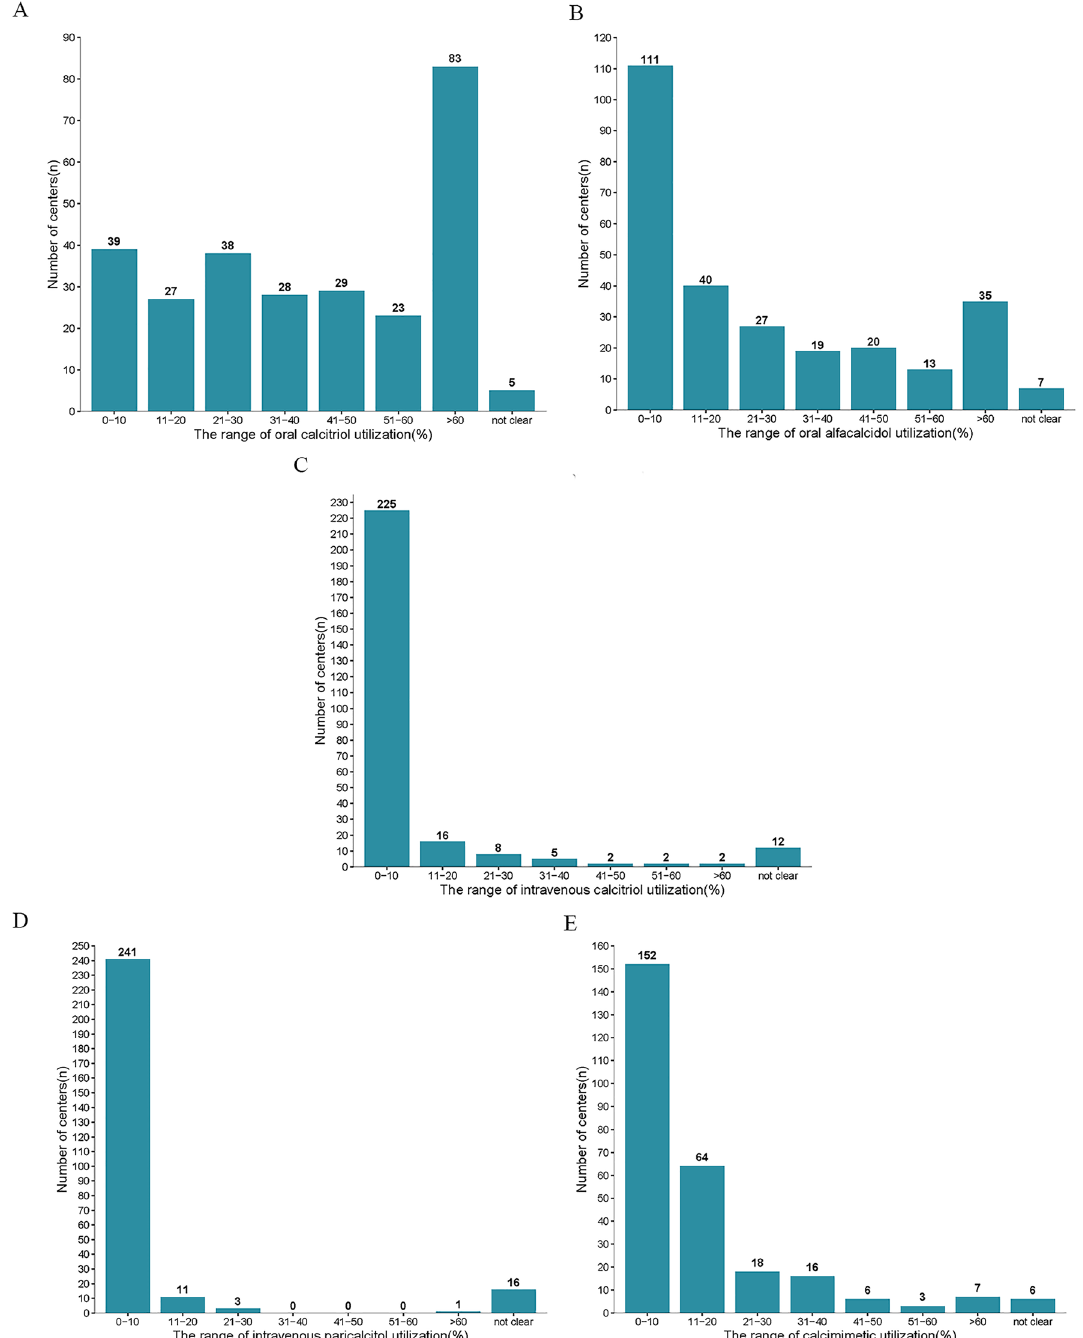
Figure 3. Distribution of utilization rates of different medications used to reduce iPTH levels in the included